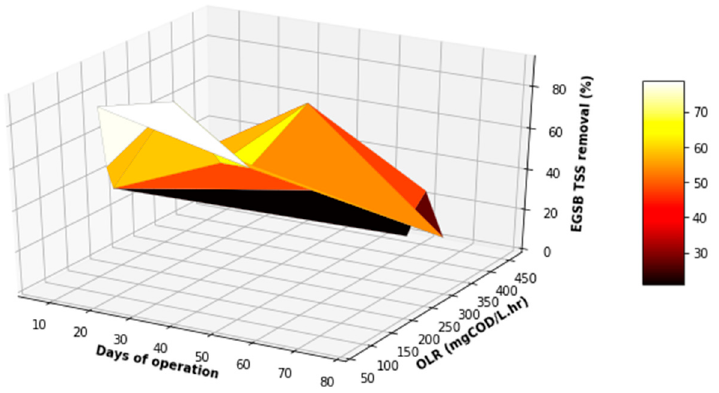
Figure 13. Variation in TSS removal with differentiated OLR during the EGSB operational time.